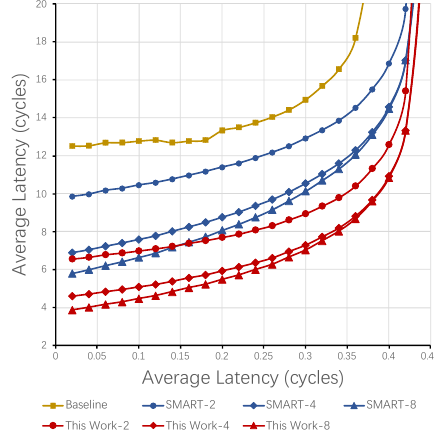
Figure 11. Impact of HPC m